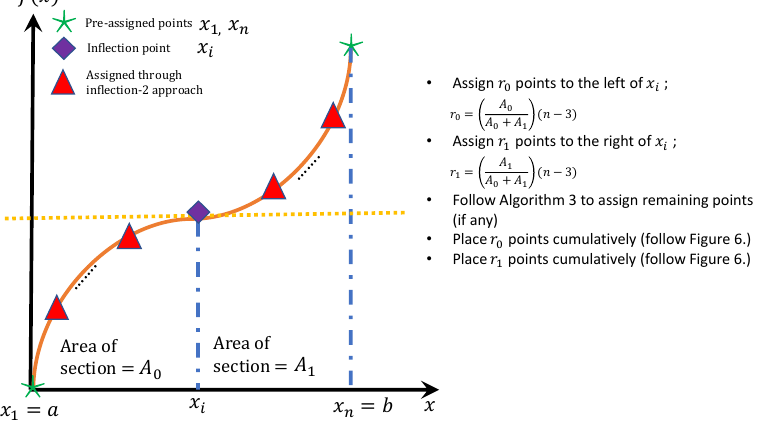
Figure 8. Pictorial representation of inflection-2 approach considering one inflection point.